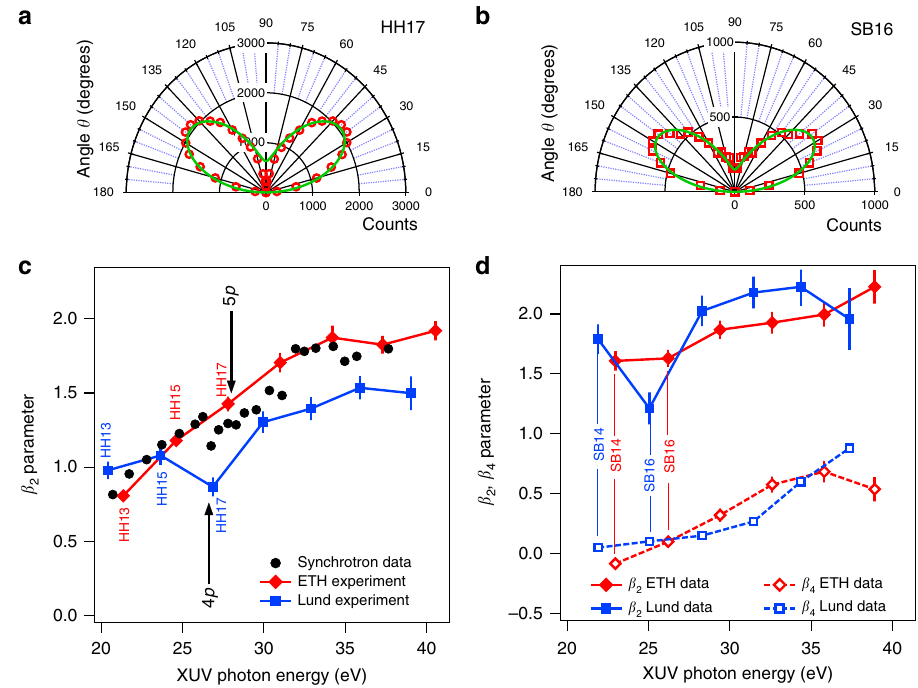
Fig. 3 Photoelectron angular distributions and β parameters. a and b represent two photoelectron angular distributions (PAD) in polar coordinates for electron kinetic energies corresponding to HH17 and SB16, respectively, as measured in the ETH experiment with the reaction microscope detector. The green solid lines are the fi t of Eq. 1, multiplied by sin( θ ) to account for the detector geometry, to the data. c Values of β 2 parameter as a function of photon energy sampled at the harmonic (solid line) obtained in the ETH (in red) and Lund (in blue) experiments. The black dots are taken from 33 and the arrows at 26.6 eV and 28 eV indicate the positions of the 3 s → 4 p and the 3 s → 5 p autoionization resonances. d Values of β 2 parameter (solid lines) and β 4 parameter (dashed lines) as a function of photon energy sampled at sideband energy positions for the ETH (in red) and Lund (in blue) experiments. In panels c and d , the data represent the mean value extracted by independent datasets, while the error bars indicate the standard